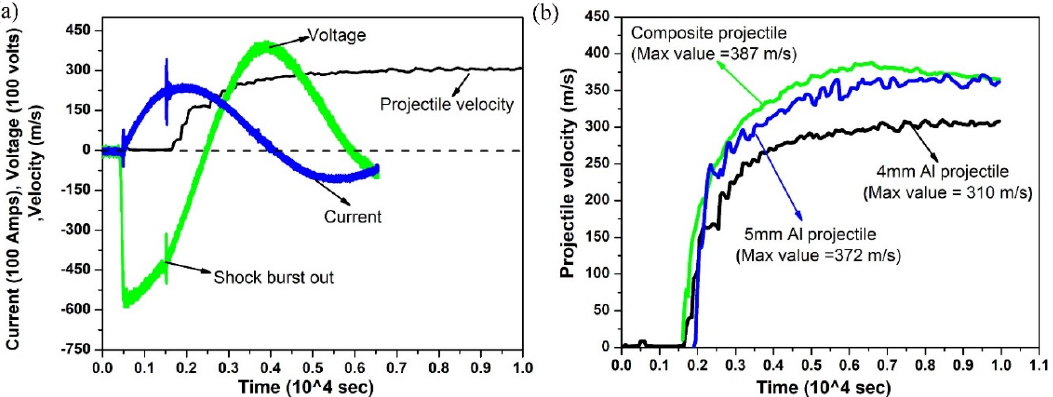
Figure 3. ( a ) Time-based evolution of voltage, current and velocity using an aluminum projectile with a 10 mm length, and ( b ) velocity comparison with different projectile configurations.